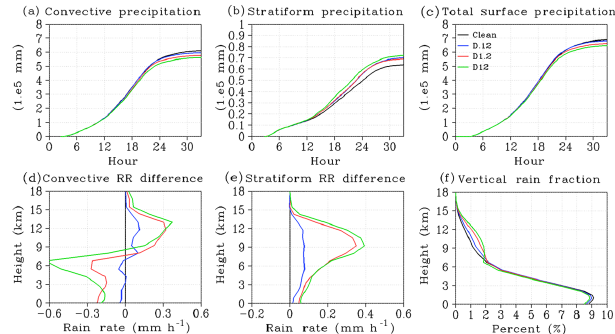
Figure 12. (a) and (b) Time series of accumulated surface precip- itation for convective and stratiform data respectively. (c) Total ac- cumulated surface precipitation for the clean and dust cases. (d) and (e) Dust case minus Clean case time-averaged vertical rain rates for convective and stratiform precipitation, respectively. (f) Fraction of total precipitation formed at each vertical level. Colors represent Clean (black), D.12 (blue), D1.2 (red), and D12 (green) cases, re-